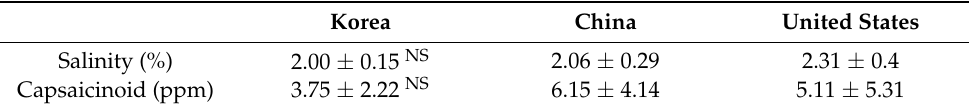
Table 1. Salinity and capsaicinoid contents of commercial kimchi manufactured in Korea, China, and the United States.